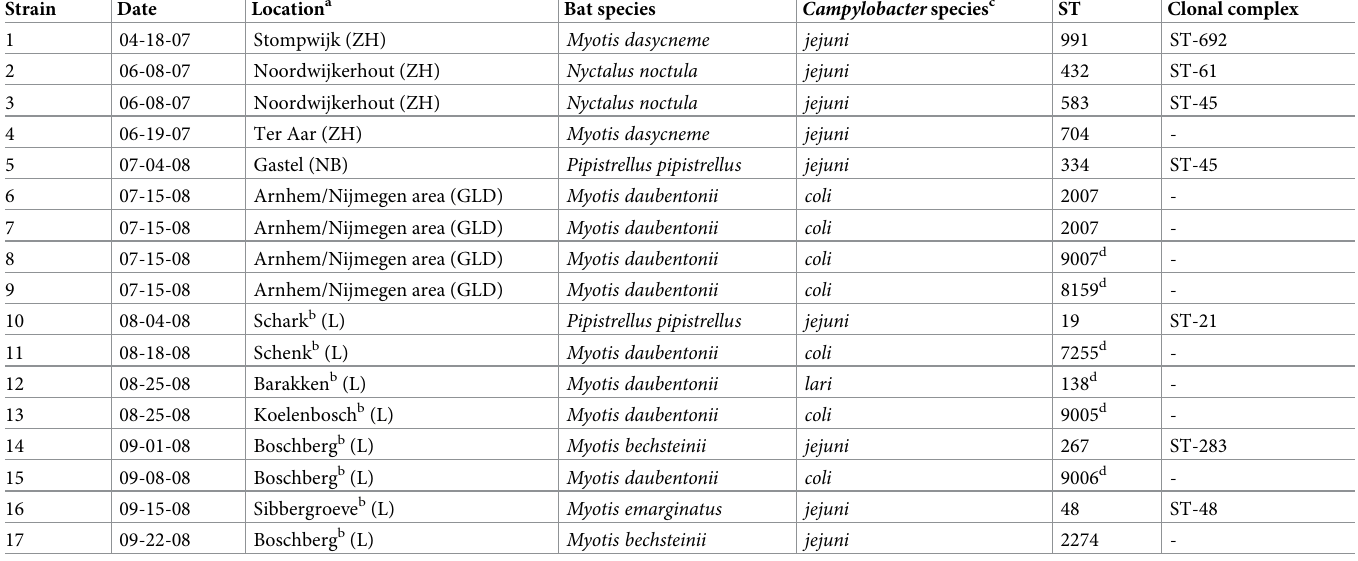
This study was biased with respect to catching sites due to dependency on ongoing research, which was mainly focusing on bats in the middle and southern part of the Netherlands. No correlation could be found between gender of the bats and Campylobacter carriage. Except for Table 2. Information of isolated strains: Catching date and -location of the bats, bat species, Campylobacter species, Sequence Type (ST) and clonal complex (if existing).